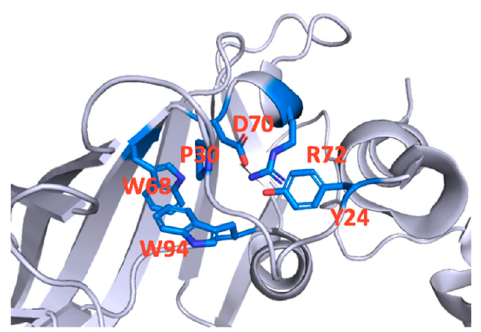
Figure 7. P30 is located at a tight turn in the α 1 β 1 loop and its substitution could alter this turn and/or interactions with or between adjacent residues such as the conserved W68, D70 or R72 in loop D, W94 in loop A or Y24 in the 1 β 1 loop.